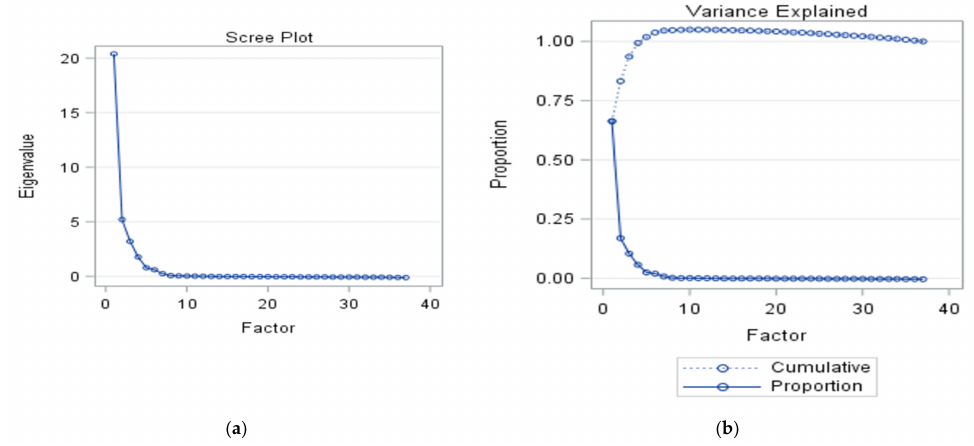
Figure 16. Scree plots ( a ) Eigenvalue vs. factors and ( b ) proportion vs. factor: five factors are retained by the PROPORTION